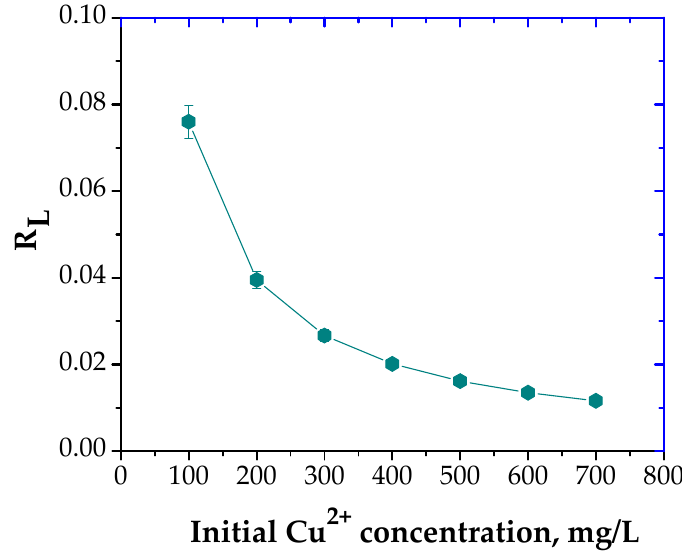
Figure 6. Plot of separation factor vs. initial Cu 2+ initial concentration.